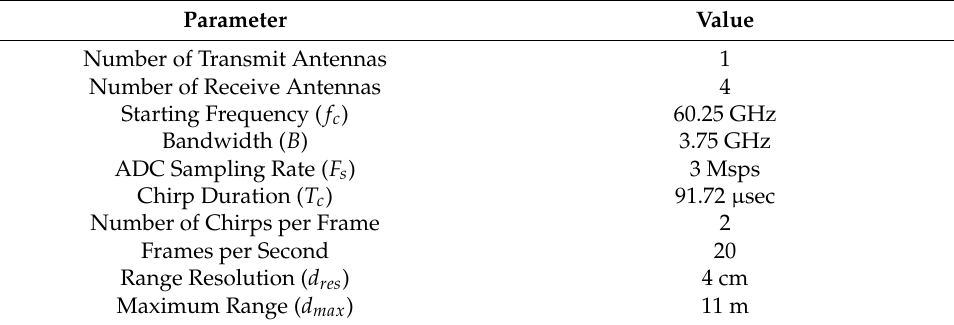
Table 2. Settings of the FMCW radar for vital sign